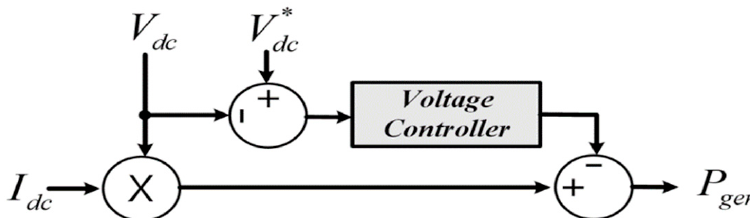
Figure 8. Calculation block diagram for distributed power generation.